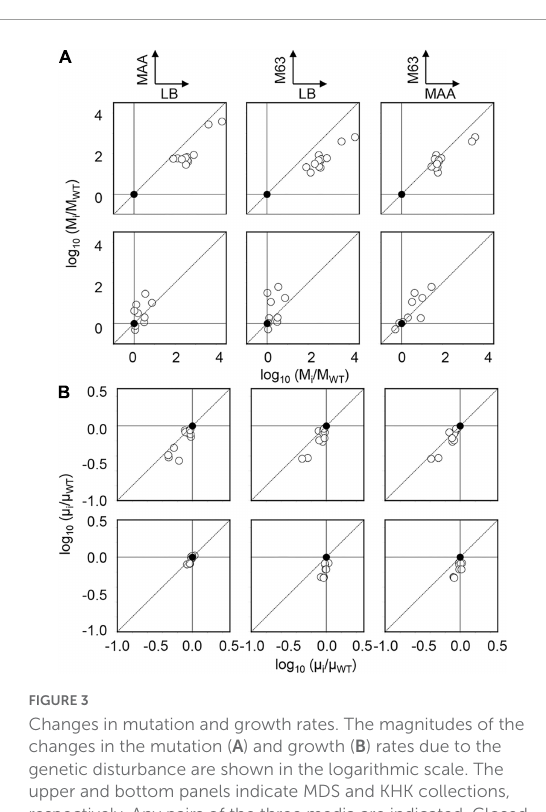
FIGURE3 Changes in mutation and growth rates. The magnitudes of the changes in the mutation ( A ) and growth ( B ) rates due to the genetic disturbance are shown in the logarithmic scale. The upper and bottom panels indicate MDS and KHK collections, respectively. Any pairs of the three media are indicated. Closed and open circles represent the parent strain and its derivatives, respectively.